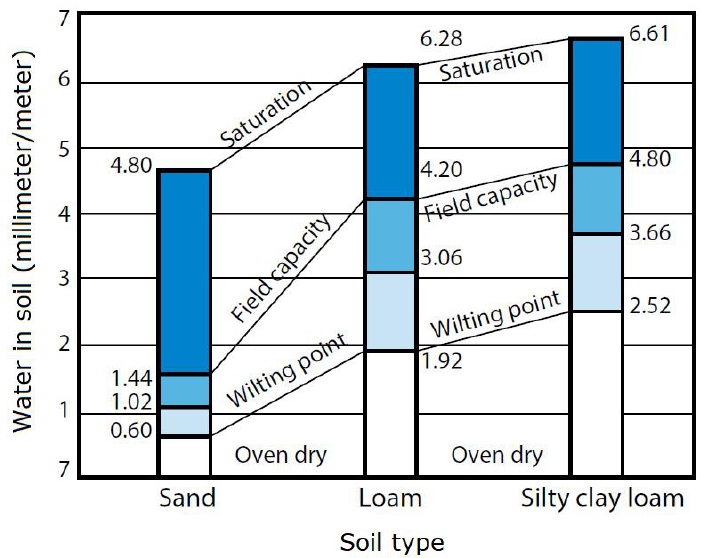
Figure 3. Typical soil water content within three soil textures (reproduced upon Ball [18], with per- mission of Noble Research Institute) .